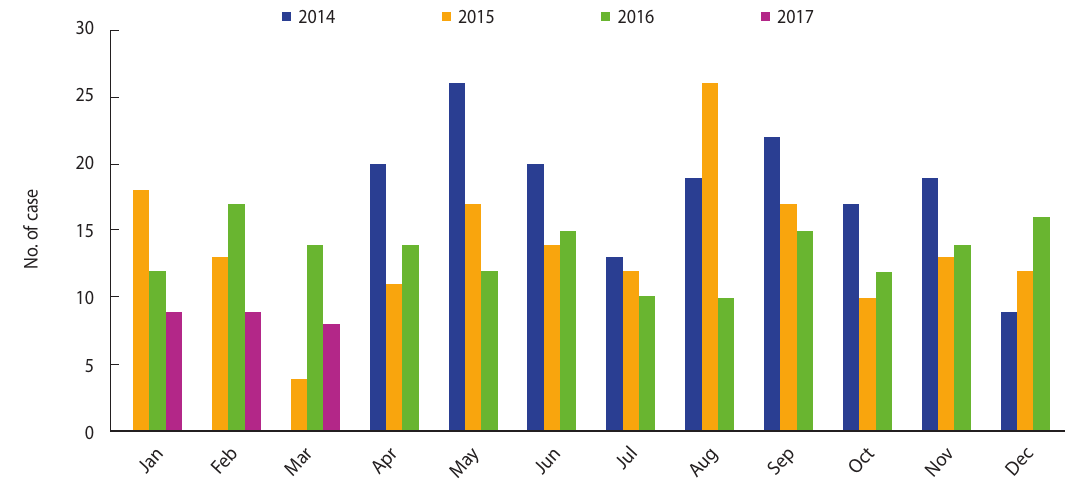
Figure 1. Distribution of fatal traffic collisions associated with drivers in Tehran, April 2014 to March